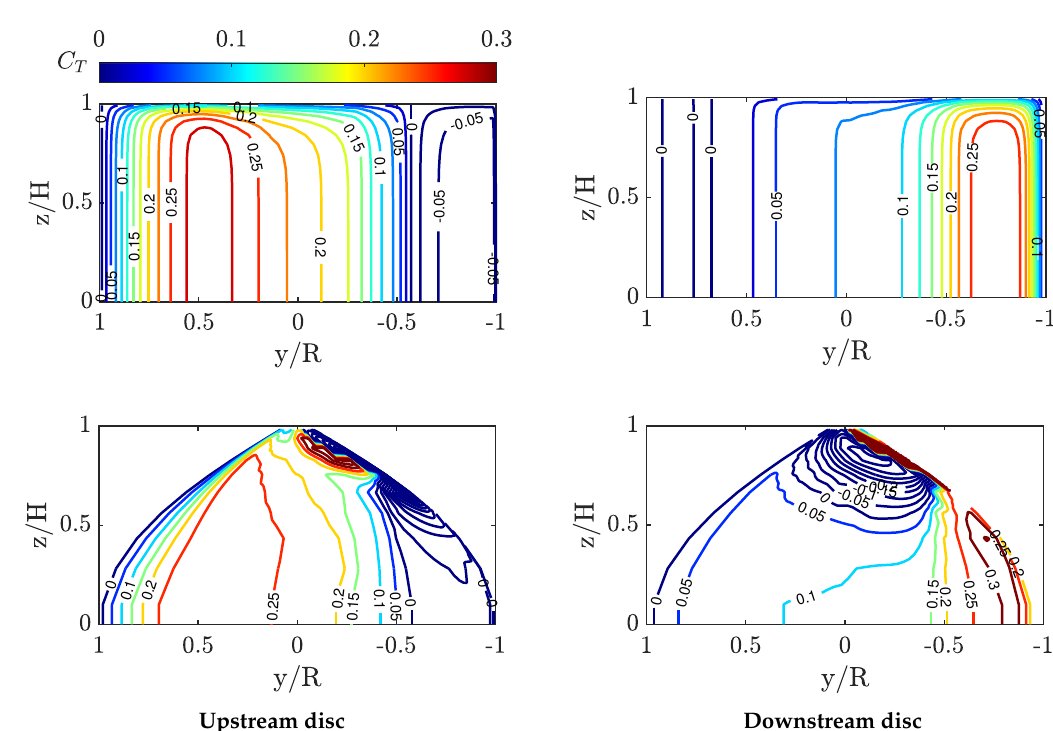
Figure 9. Tangential force coefficient C T distribution at the upstream disc ( left ) and downstream disc ( right ) along semi-span for micro H-shaped ( top ) and micro Troposkein rotor ( bottom ) at TSR = 2.4. View from